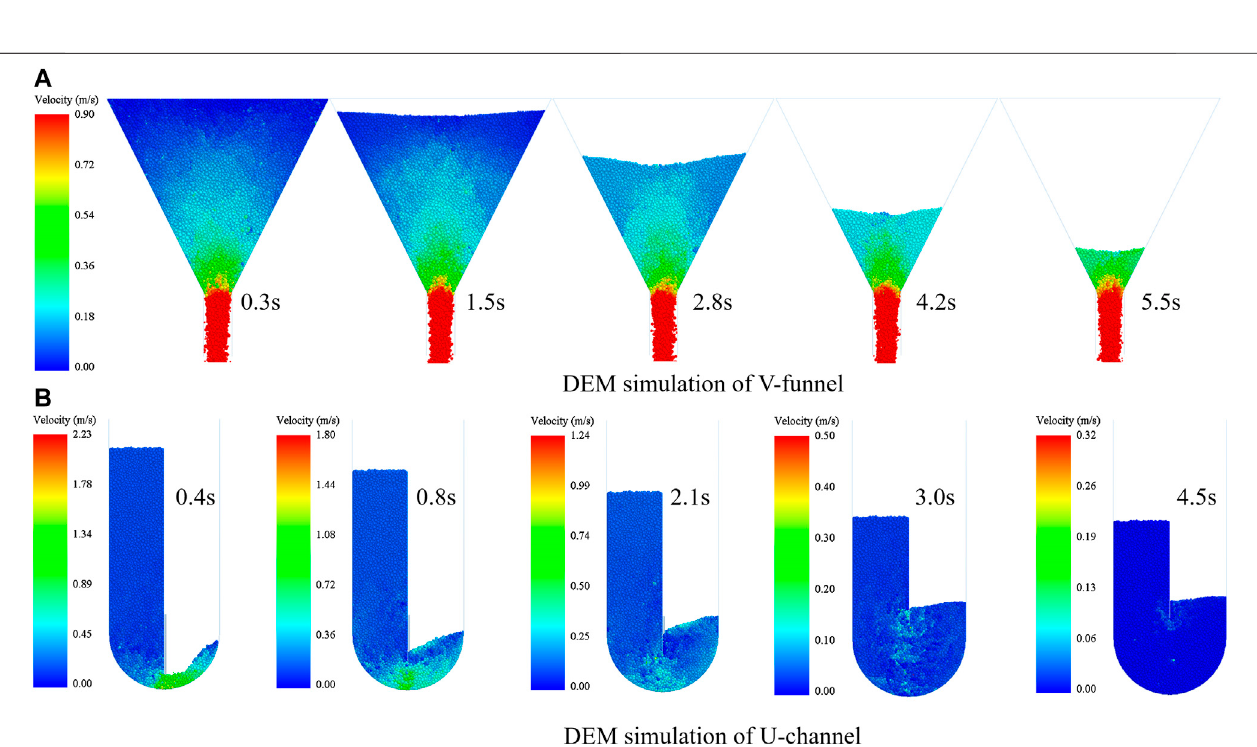
FIGURE 9 | Simulation of V-funnel and U-channel: (A) DEM simulation of V-funnel and (B) DEM simulation of U-channel.